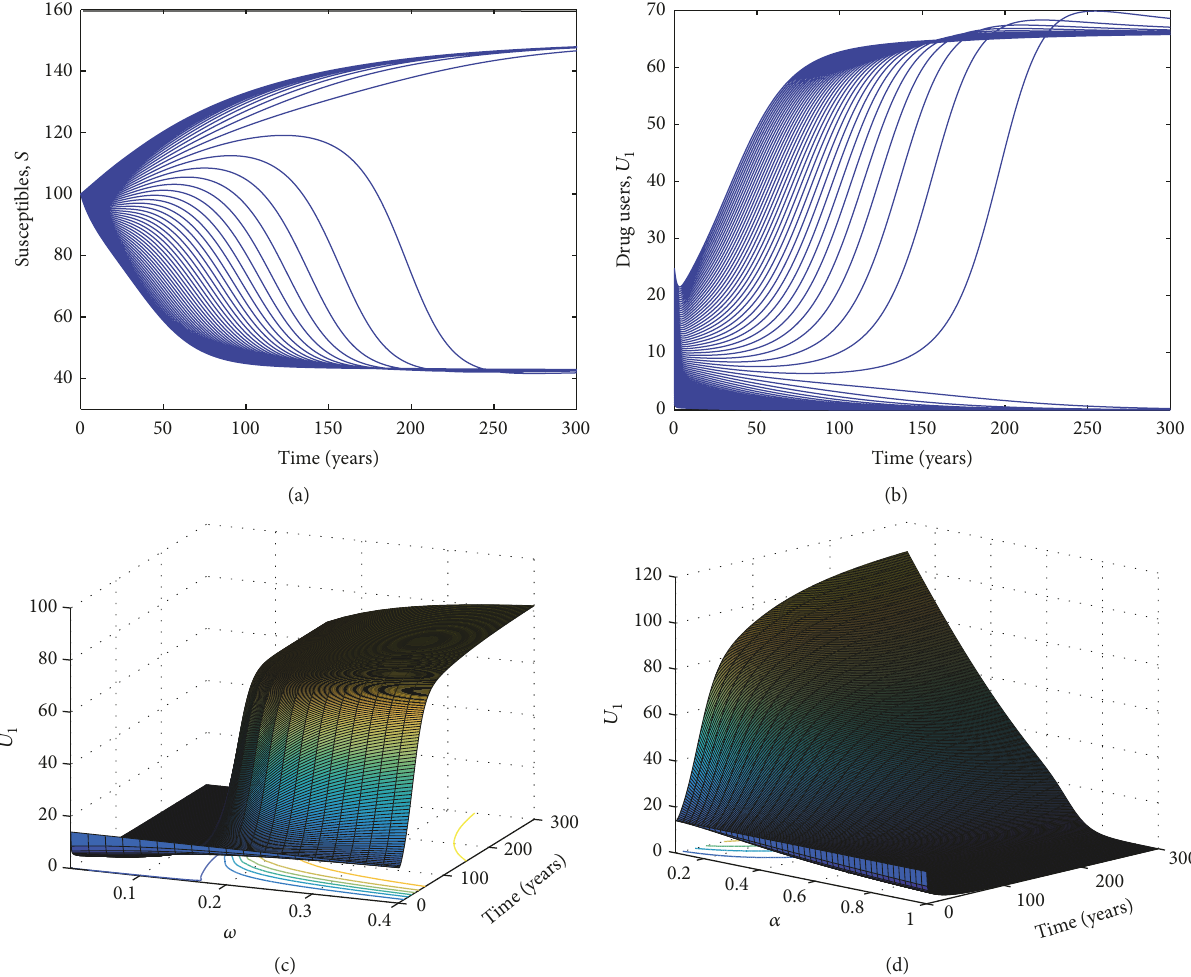
Figure 5: (a) and (b) illustrate the dependence of the heroin epidemic extinction or persistence on the initial states provided to the model. Parameters used include 𝜔 = 0.15 , 𝛽 = 0.001 , 𝛿 1 = 0.002 , 𝛿 2 = 0.001 , 𝜉 = 0.015 , 𝜇 = 0.01 , 𝛼 = 0.9 , 𝑝 = 0.467 , 𝜎 = 0.1 , and Λ = 1.5. With these parameters the corresponding 𝑅 0 = 0.7506. (c) The figure illustrates the impact of increasing parameter 𝜔 (the extent of saturation of treatment) on heroin users when 𝑅 0 < 1 . Parameters used include 𝛽 = 0.001 , 𝛿 1 = 0.002 , 𝛿 2 = 0.001 , 𝜉 = 0.015 , 𝜇 = 0.01 , 𝛼 = 0.9 , 𝑝 = 0.46 , 𝜎 = 0.1 , and Λ = 1.5 which correspond to 𝑅 = 0.7427 < 1. (d) The figure shows the effect of treatment 𝛼 on heroin users 𝑈 0 1 when all other parameters and initial conditions are